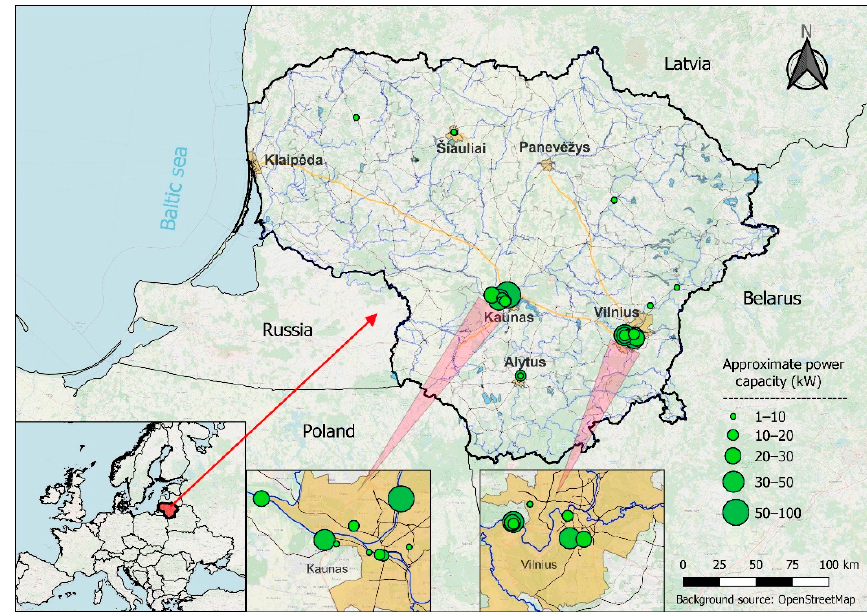
Figure 1. Energy recovery potential in the municipal water infrastructure of Lithuania.